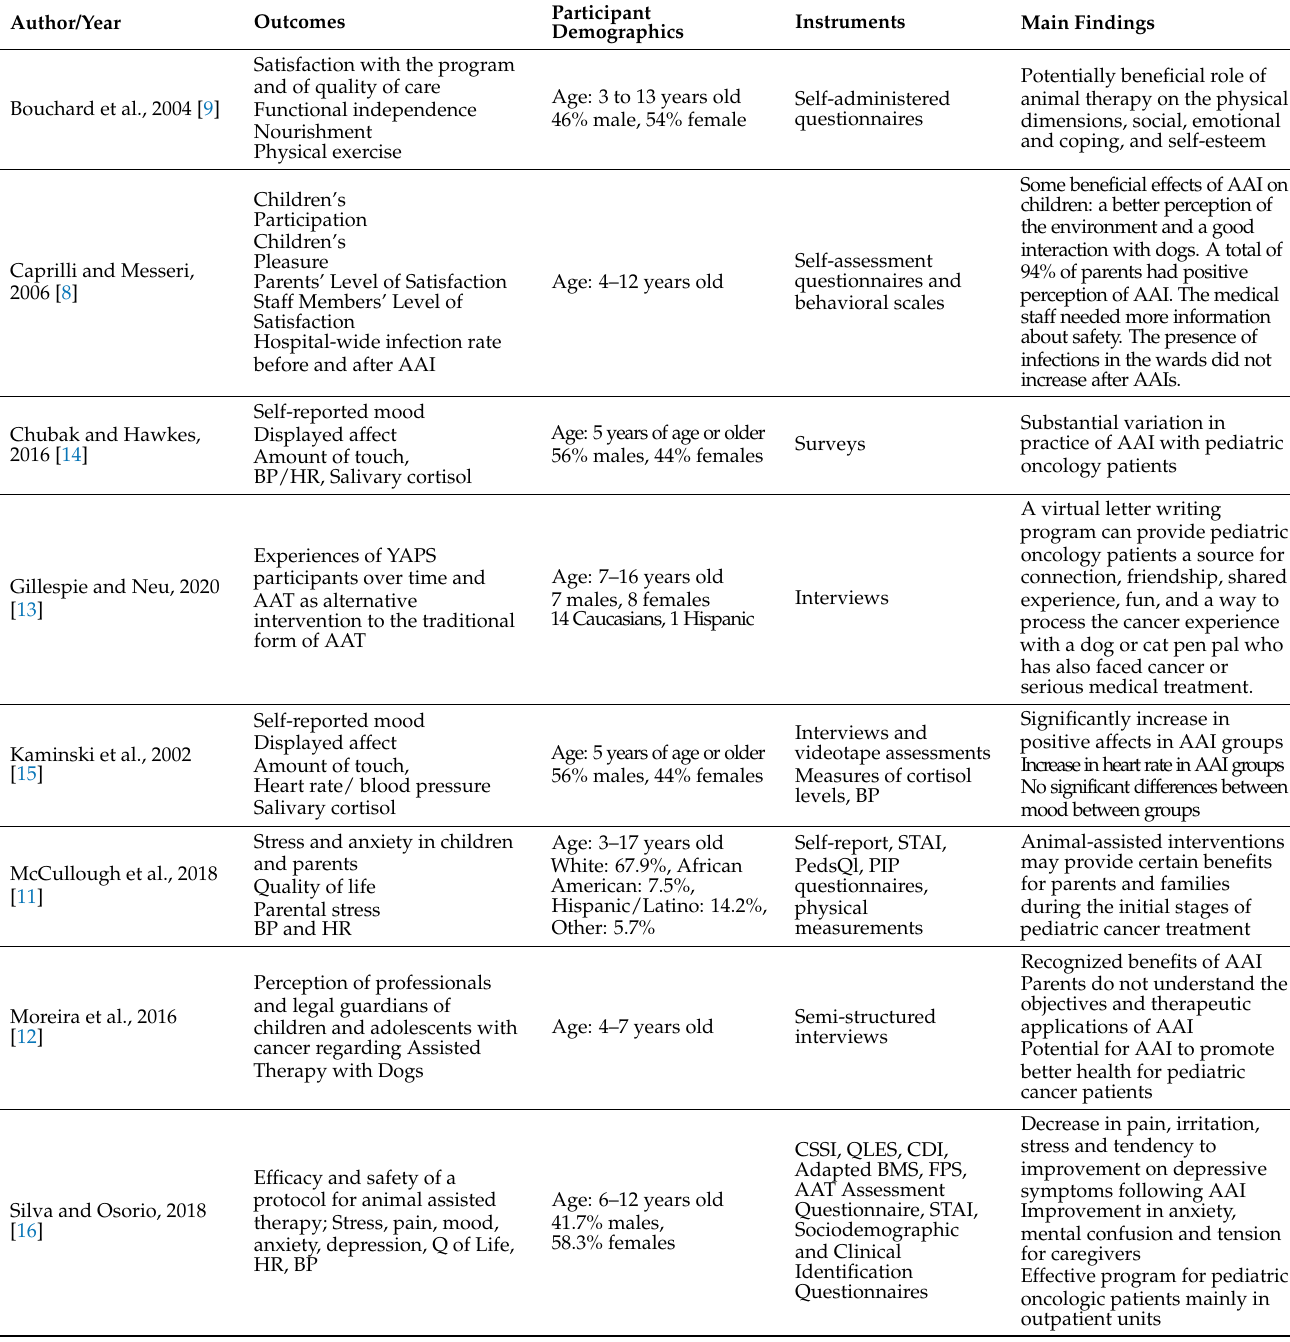
Table 1. AAI and Pediatric Oncology